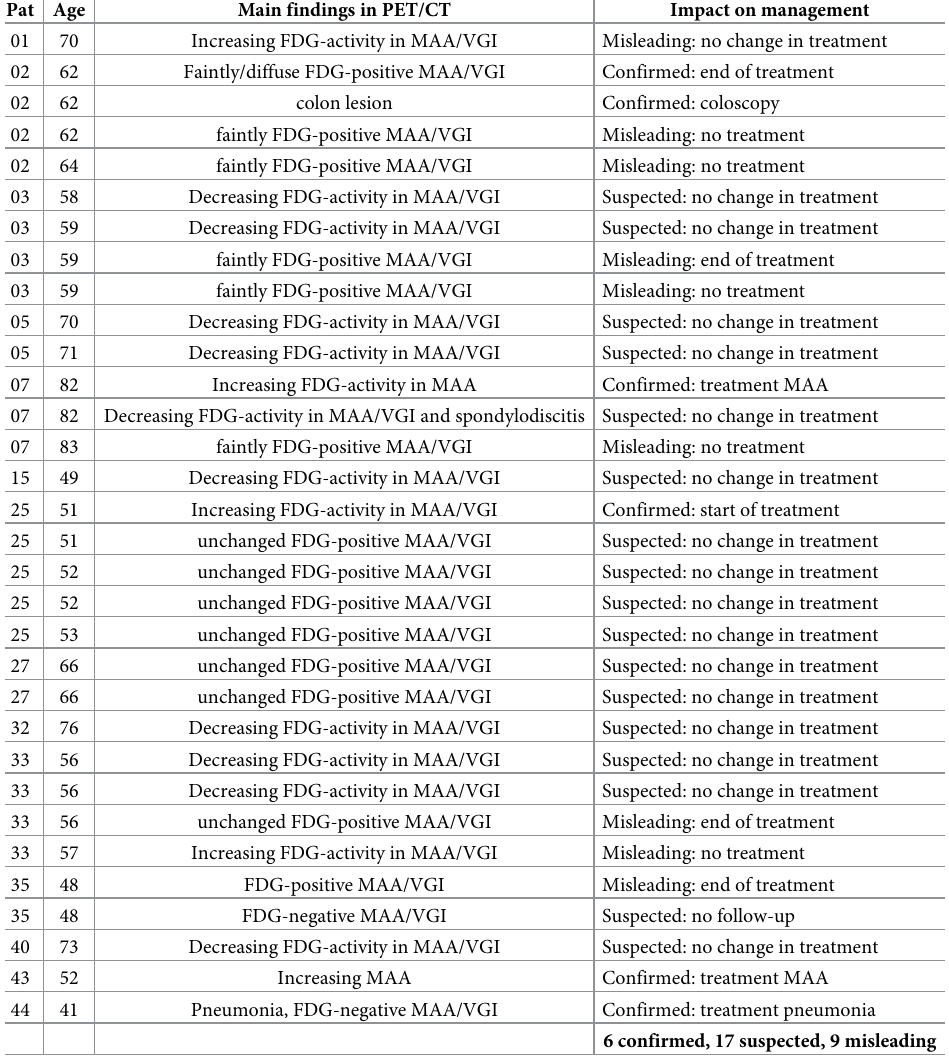
Table 6. Impact on patient management of follow-up PET/CT scans with the referral question: Follow-up MAA/ VGI (n =